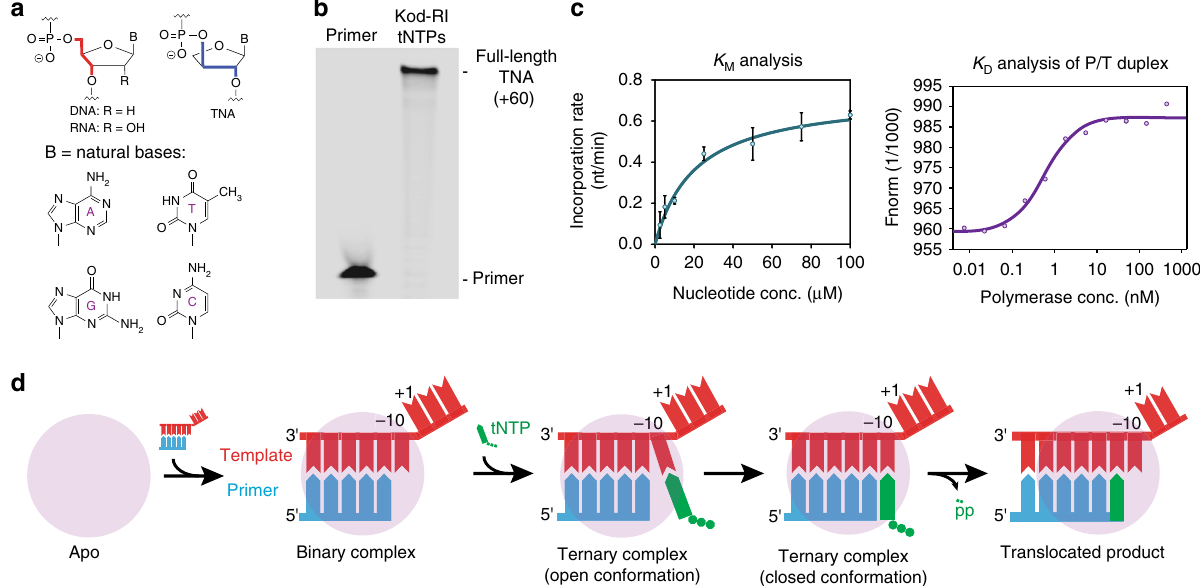
Fig. 1 TNA synthesis by Kod-RI. a Molecular structures comparing TNA to DNA and RNA. b Denaturing PAGE showing TNA synthesis on a library of degenerate DNA templates. c Functional analysis of TNA substrate and primer template binding. Error bars represent the average of three independent trials. d Schematic view of the TNA synthesis pathway where each cartoon image represents an elucidated structure described in this